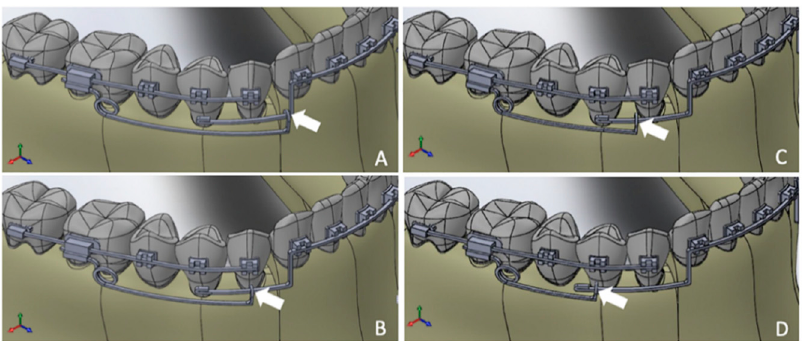
Figure 3. FEM tested: ( A ) FEM 1; ( B ) FEM 2; ( C ) FEM 3; ( D ) FEM 4. Arrows indicate the exact location of the points of force application evaluated.